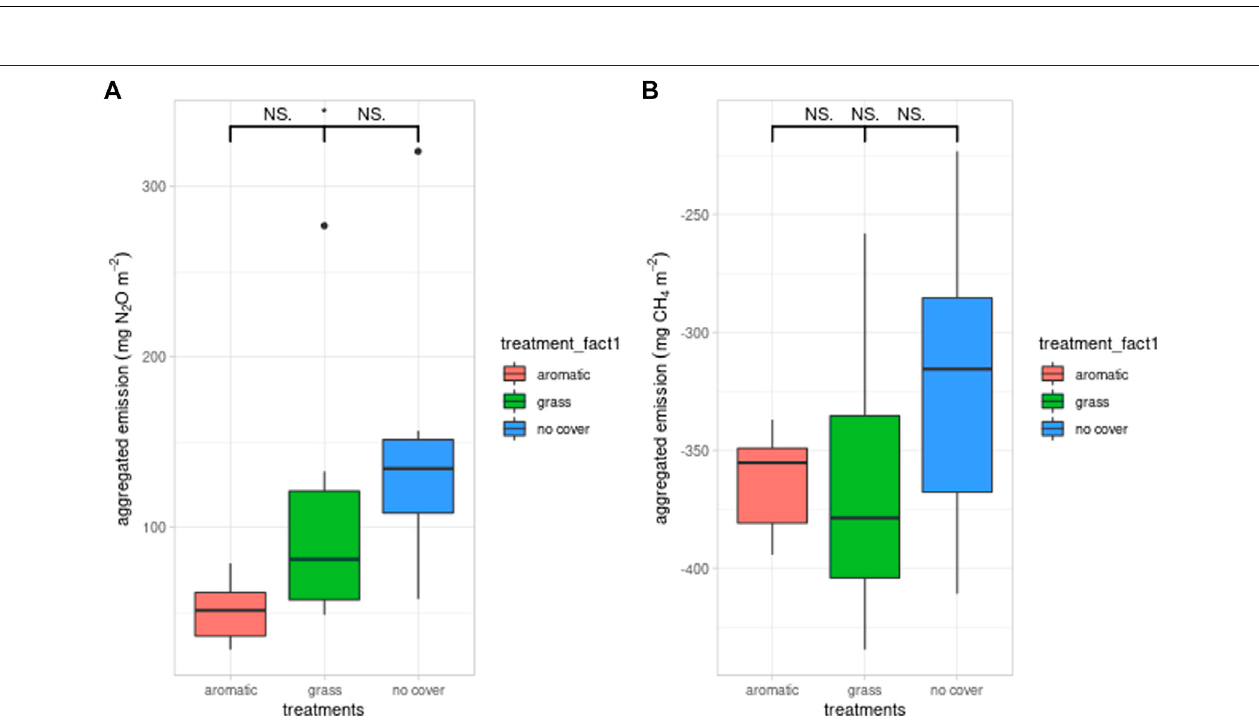
FIGURE 11| Boxplotsof the aggregated N 2 O (A) and CH 4 (B) exchange from CS11 by the diversi fi cation treatment; aromatic herbs, grass and no cover (control).